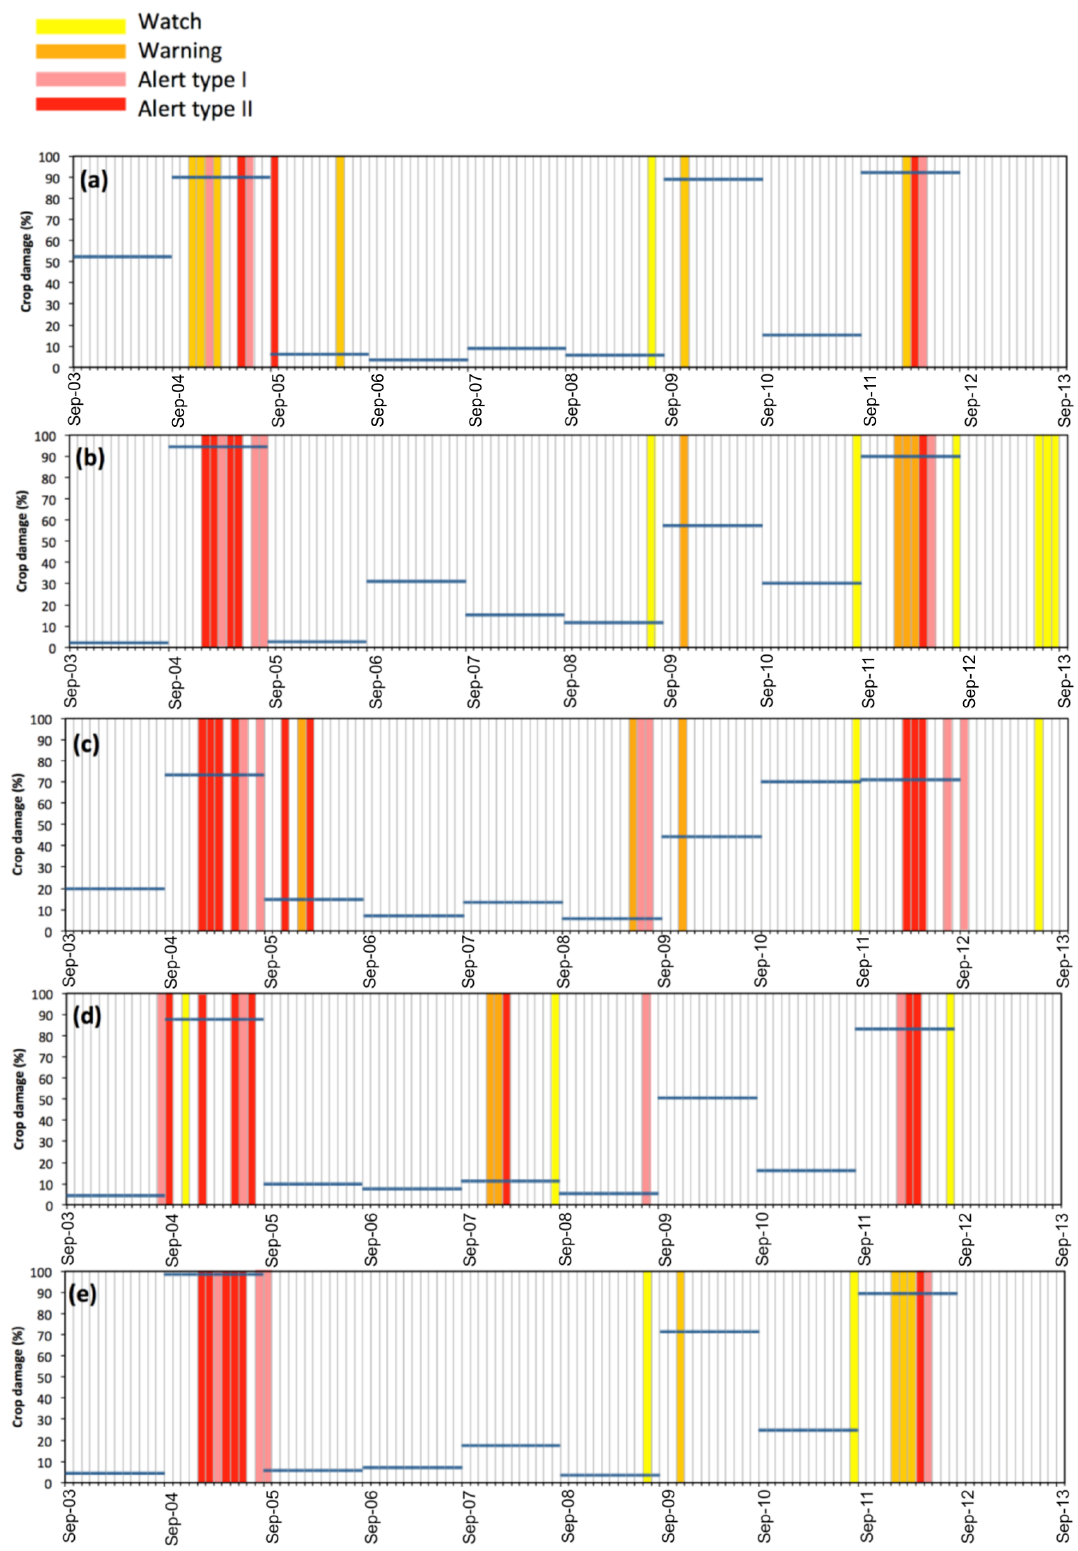
Figure 6. Evolution of the combined drought indicator (CDI) from 2003–2013 and comparison with agricultural crop damage intensity (blue lines) for the five agricultural regions studied: (a) Campiña de Cádiz, (b) Campiña Baja, (c) Pedroches, (d) Norte/Antequera and (e) la